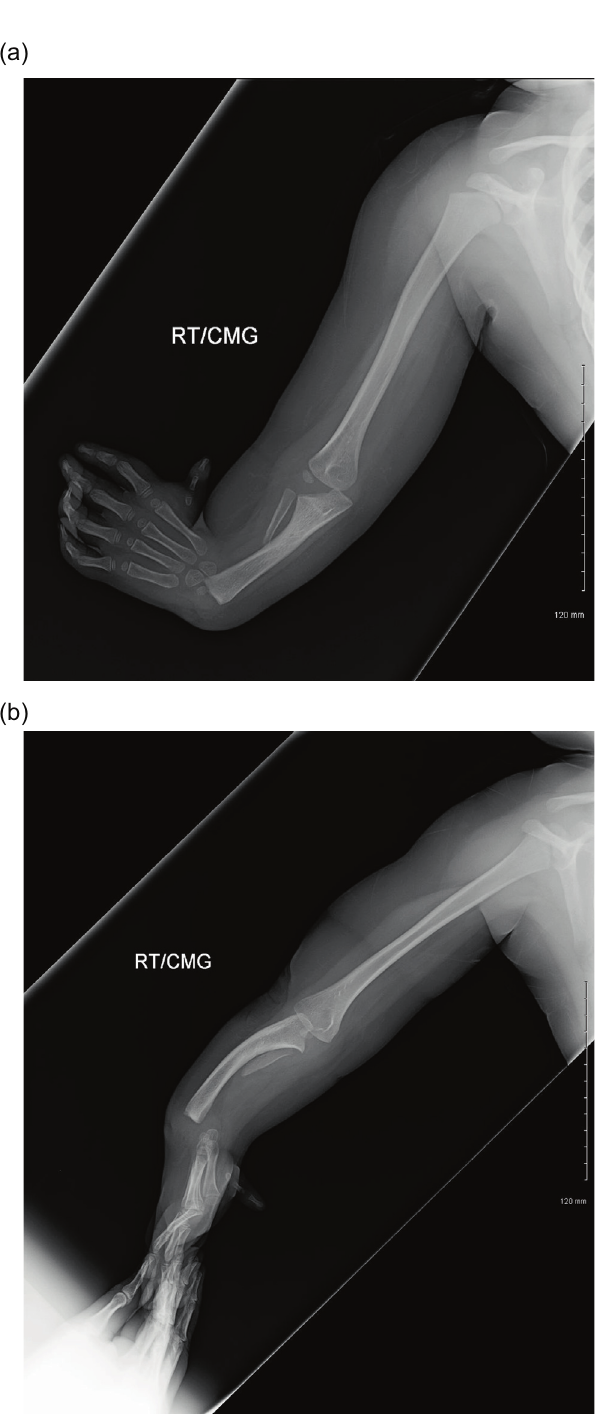
Figure 25. AP and lateral radiographs of left hand of a four-year- old boy with radial club hand before surgery.